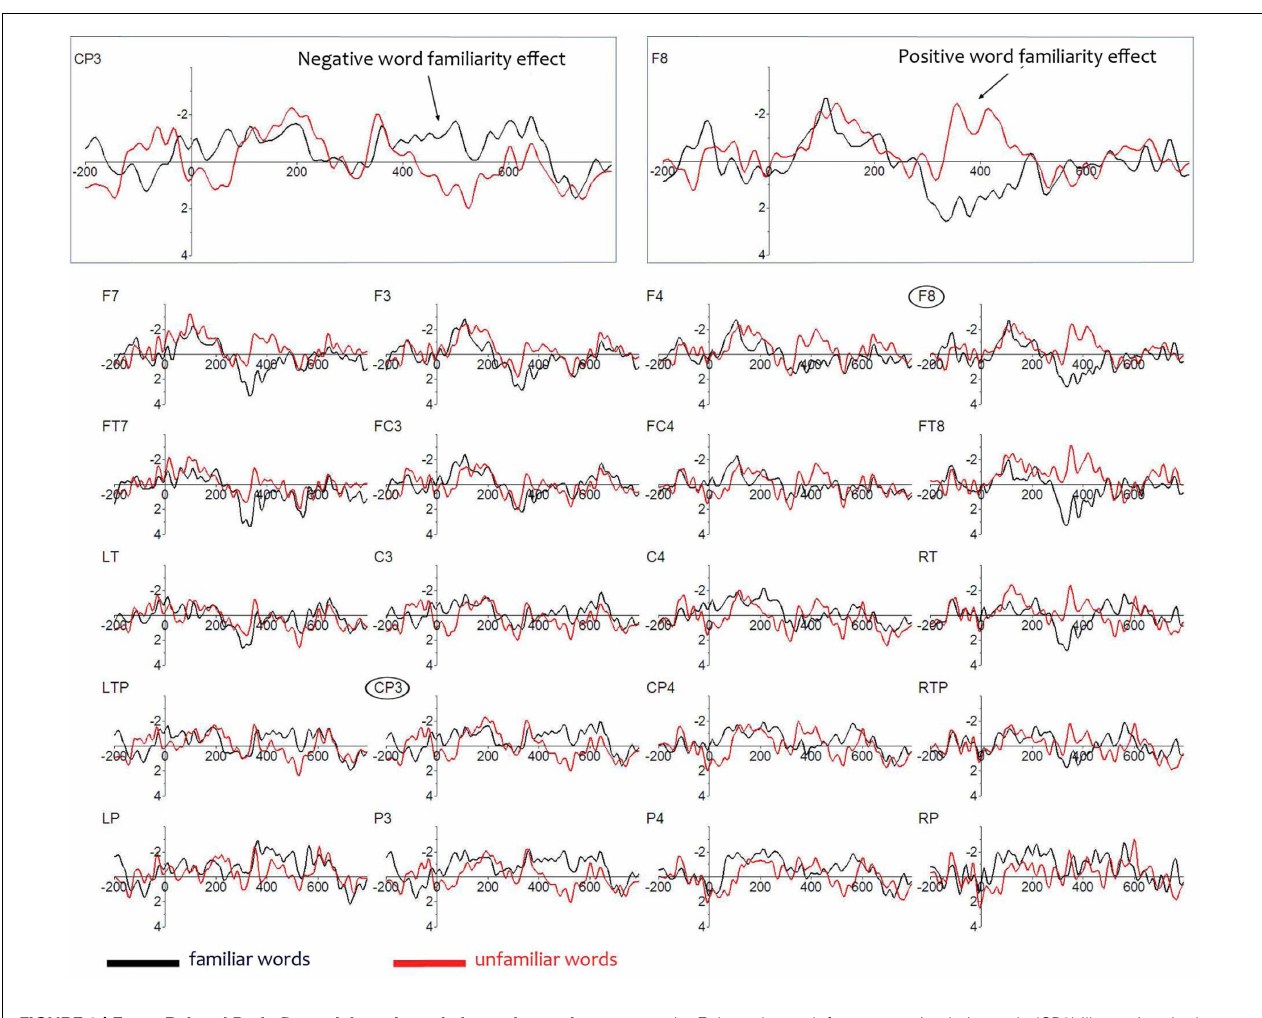
FIGURE 2 | Event-Related Brain Potentials on lateral electrodes to the familiarized target and unfamiliar control words in the sentences; negativity is plotted upwards. Electrodes are laid out as they are on the